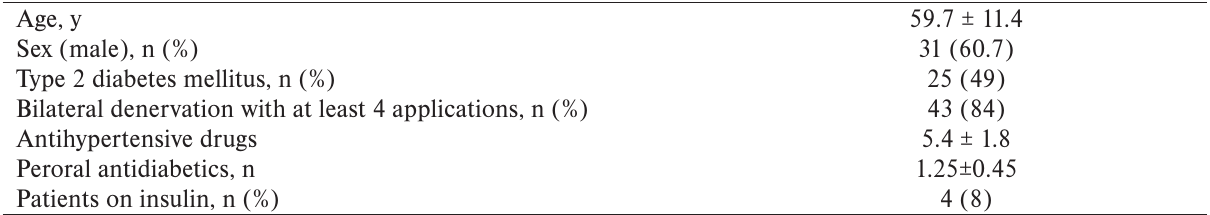
Table 1. Baseline patient characteristics, n = 51.